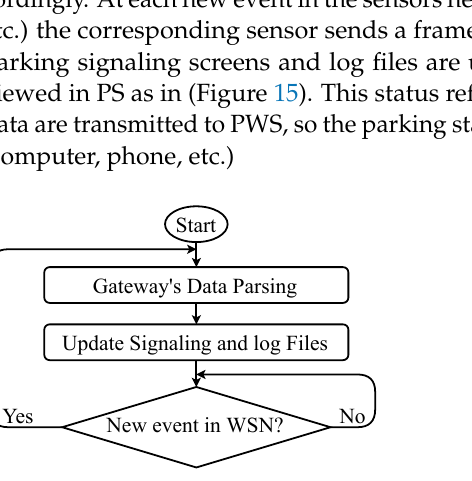
Figure 16. Flowchart of the local parser Parking IoT sensors